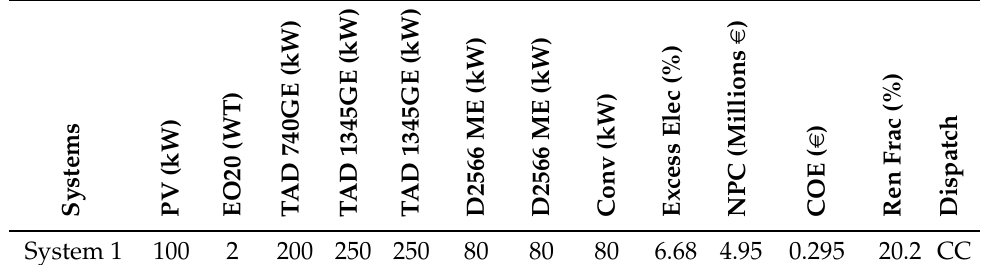
Table 8. Scenario 1 Optimization results.